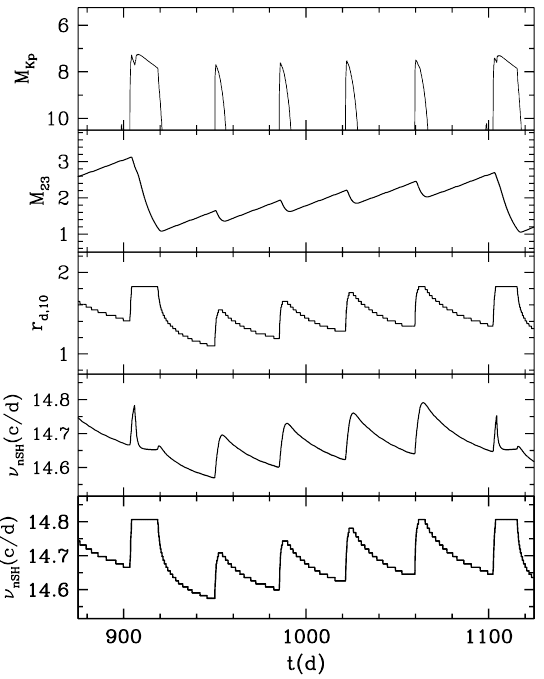
Figure 2: A calculation of the pDI model for a SU UMa system. Shown are (i) the Kepler light curve, (ii) the disk mass, in units of 10 23 g, (iii) the outer disk radius, in units of 10 10 cm, (iv) the nSH frequency cal- culated using the Larwood formula, and (v) the nSH fre- quency calculated using the approximate formula given OK13abc, taking η = 1 .